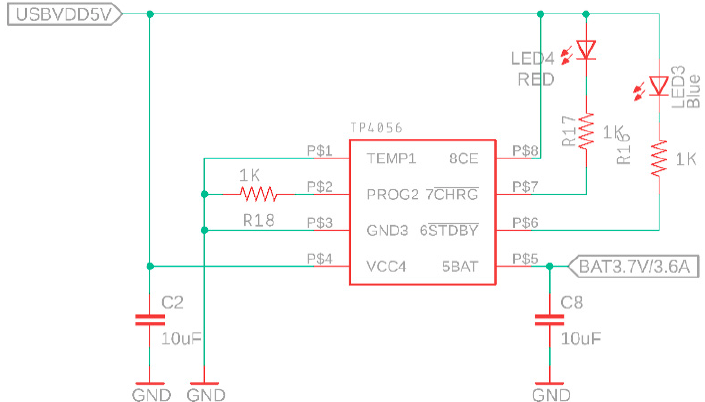
Figure 8. Schematic diagram of the charging module.